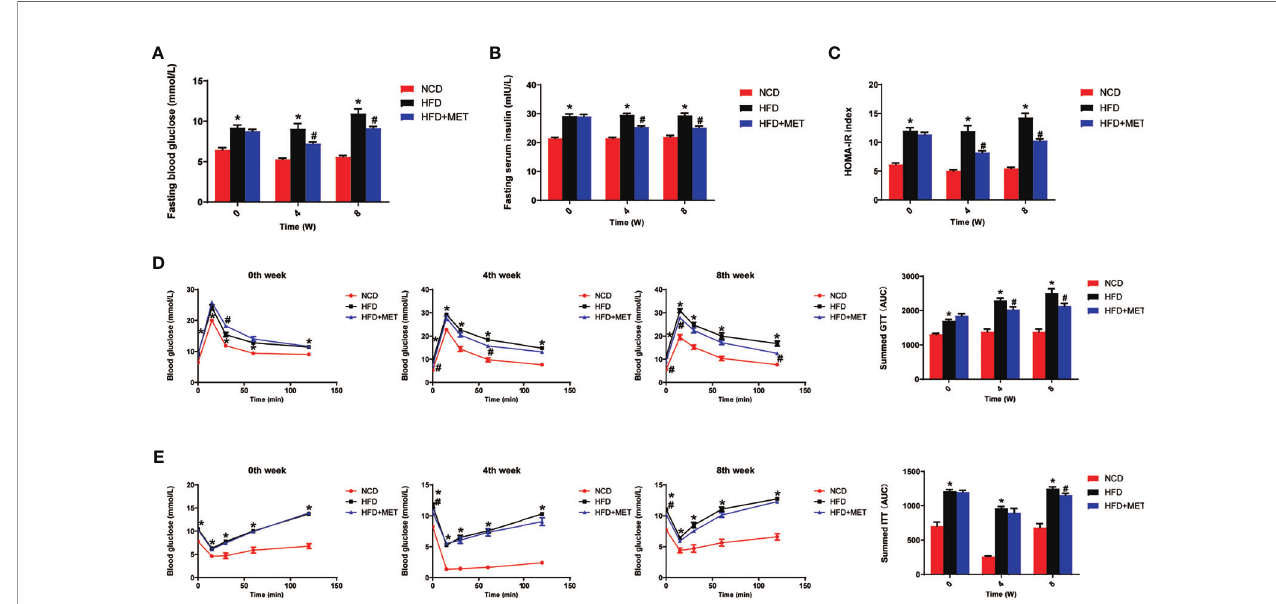
FIGURE 2 | Improvement of insulin sensitivity by MET. (A) Fasting blood glucose. (B) Fasting serum insulin. (C) HOMA-IR. (D) GTT at 0, 4, 8 weeks of MET treatment. (E) ITT at 0, 4, 8 weeks of MET treatment. GTT and ITT was performed by intraperitoneal injection of glucose and insulin. Data are presented as the mean ± SEM (n = 10). * P < 0.05 HFD versus NCD, # P < 0.05 HFD+MET versus